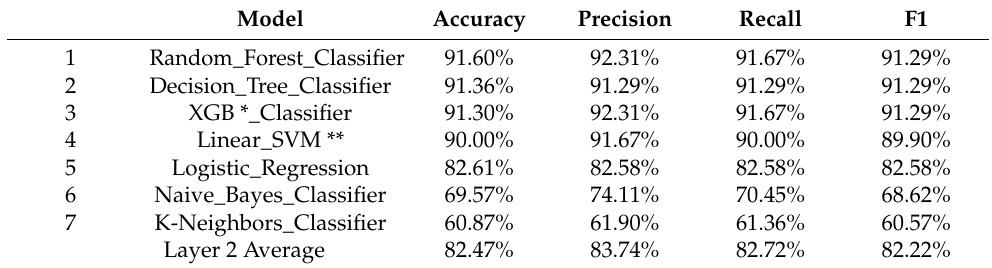
Table 5. Layer 2—Accuracy. Figure 4. Layer 1 for prediction of skeletal jaw bases I, II and III — Accuracy. * XGB — eXtreme Gra- dient Boosting. ** SVM — Support Vector Machine. Table 5. Layer 2 — Accuracy.